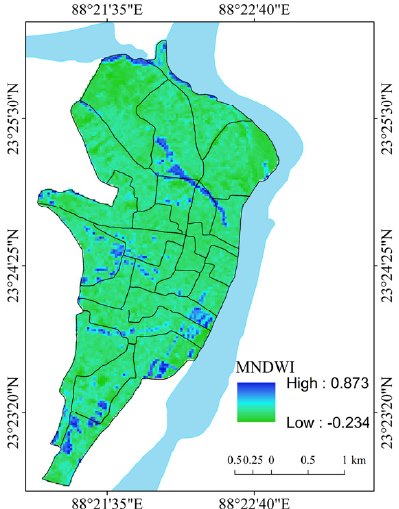
Figure 22. MNDWI (2000).